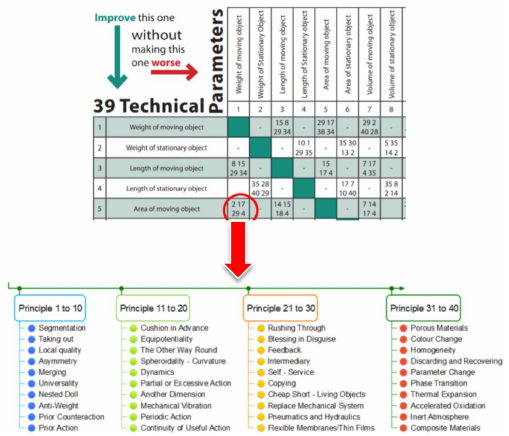
Figure 3. Example of a subset of the TRIZ 39 × 39 contradiction matrix ( top ) linking to the 40 inventive principles ( bottom ) [30,32]. These are designed to be generic to multiple industries and applications, thus do not specify